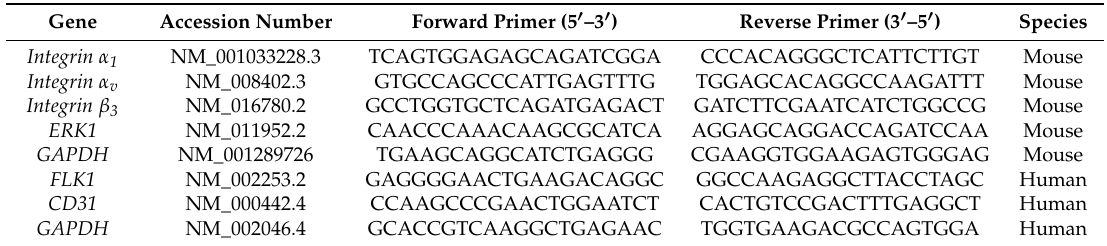
Table 1. Primer sequences used for quantitative real-time polymerase chain reaction